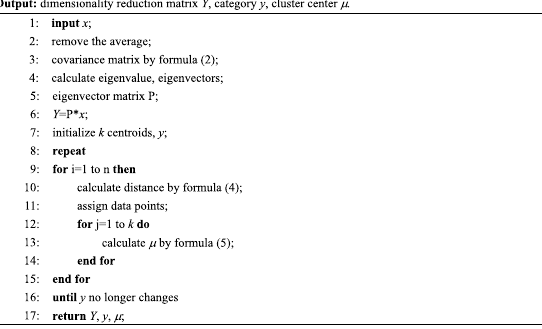
Algorithm 2. Feature dimensionality reduction and